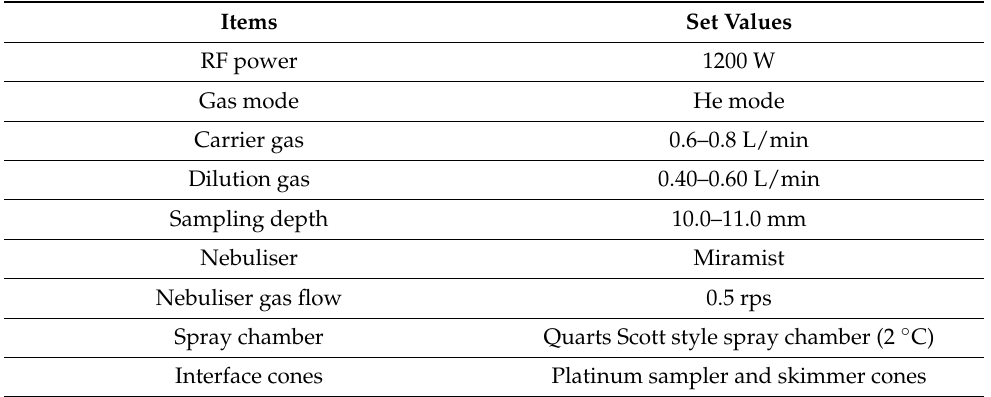
Table 1. Operational condition of